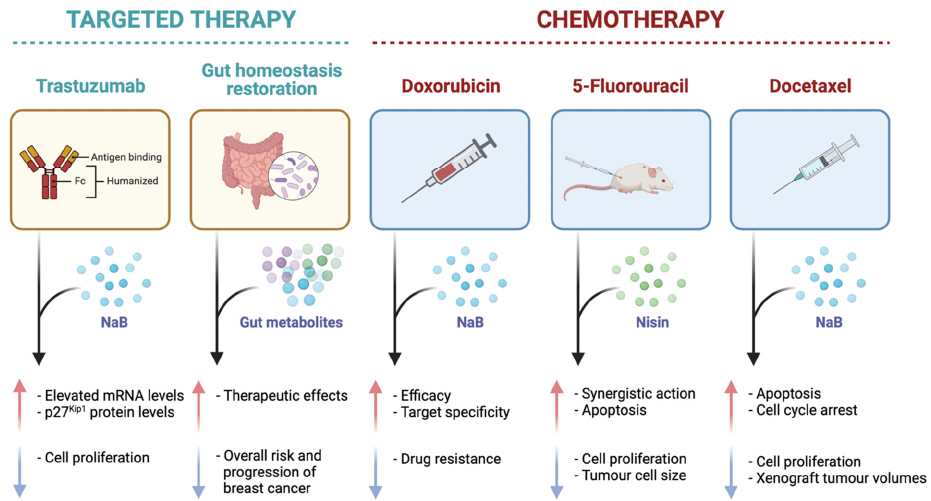
Figure 6. A diagrammatic representation of the effects of specific gut metabolites, sodium butyrate (NaB) and nisin, on common targeted cancer therapies, trastuzumab and gut homeostasis restoration, and standard chemotherapies (doxorubicin, 5-fluorouracil, and docetaxel) as evident in in vitro and in vivo studies in the literature. The red arrow is indicative of an increase in a certain effect, and the blue arrow is representative of a decrease in a certain effect.